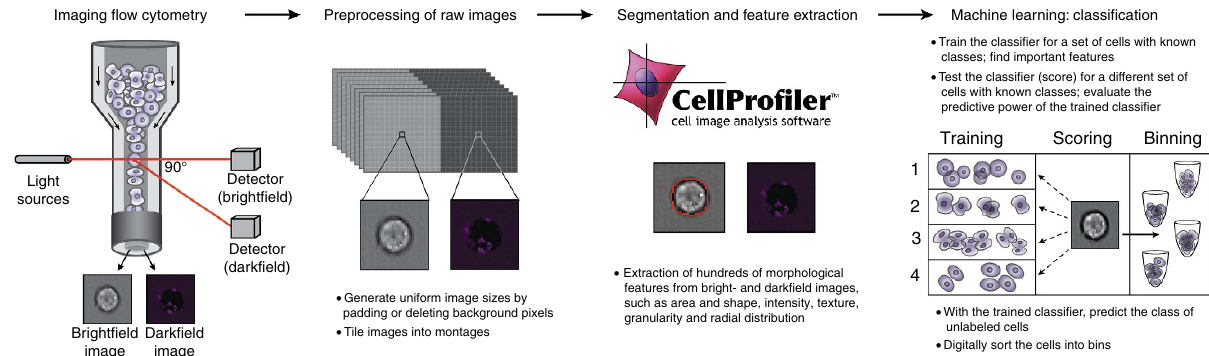
Figure 1 | Label-free imaging flow cytometry workflow. First the brightfield and darkfield images of the cells are measured by an imaging flow cytometer. The brightfield and darkfield images depict the light transmitted through the cell and light scattered from the cells within a cone centered at a 90 (cid:2) angle, respectively. Then the images are preprocessed, where we reshape the images to have their sizes coincide and tile them to montages of 15 (cid:2) 15 images. The montages are loaded into the open-source image software CellProfiler that we use to segment the cells’ brightfield images and to extract morphological features from the images. Finally, we apply supervised machine learning such as classification. For this purpose we need an annotated set of cells where the actual cell state is known to train the classifier and to test its predictive power. Once the classifier is trained it is used to predict the state of unlabelled cells and to digitally sort the cells into